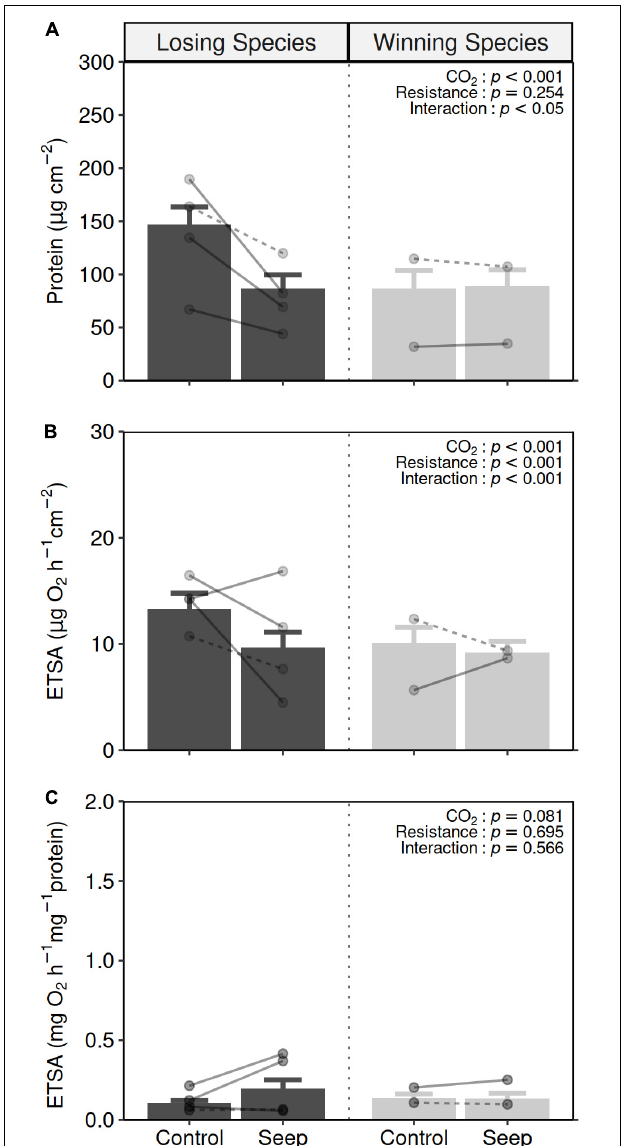
FIGURE 3 | Mean ( ± SE) protein per surface (A) , ETSA per coral surface area (B) and ETSA per protein contents (C) in losing species (black bars), and winning species (gray bars) specimens transplanted from the control areas to the control areas (control) and elevated p CO 2 areas (seep) for 4–5 months (losing species specimens: control n = 14, seep n = 5; winning species specimens: control n = 20, seep = 16). Points and lines show the mean and response per species with dashed and plain lines representing species from Shikine and Normanby CO 2 seeps, respectively (see Supplementary Table 3 ). Two-way GLMM: CO 2 condition x resistance with Species as a random factor) results are presented in the top-right of each panel (see Supplementary Table 4 for more detailed